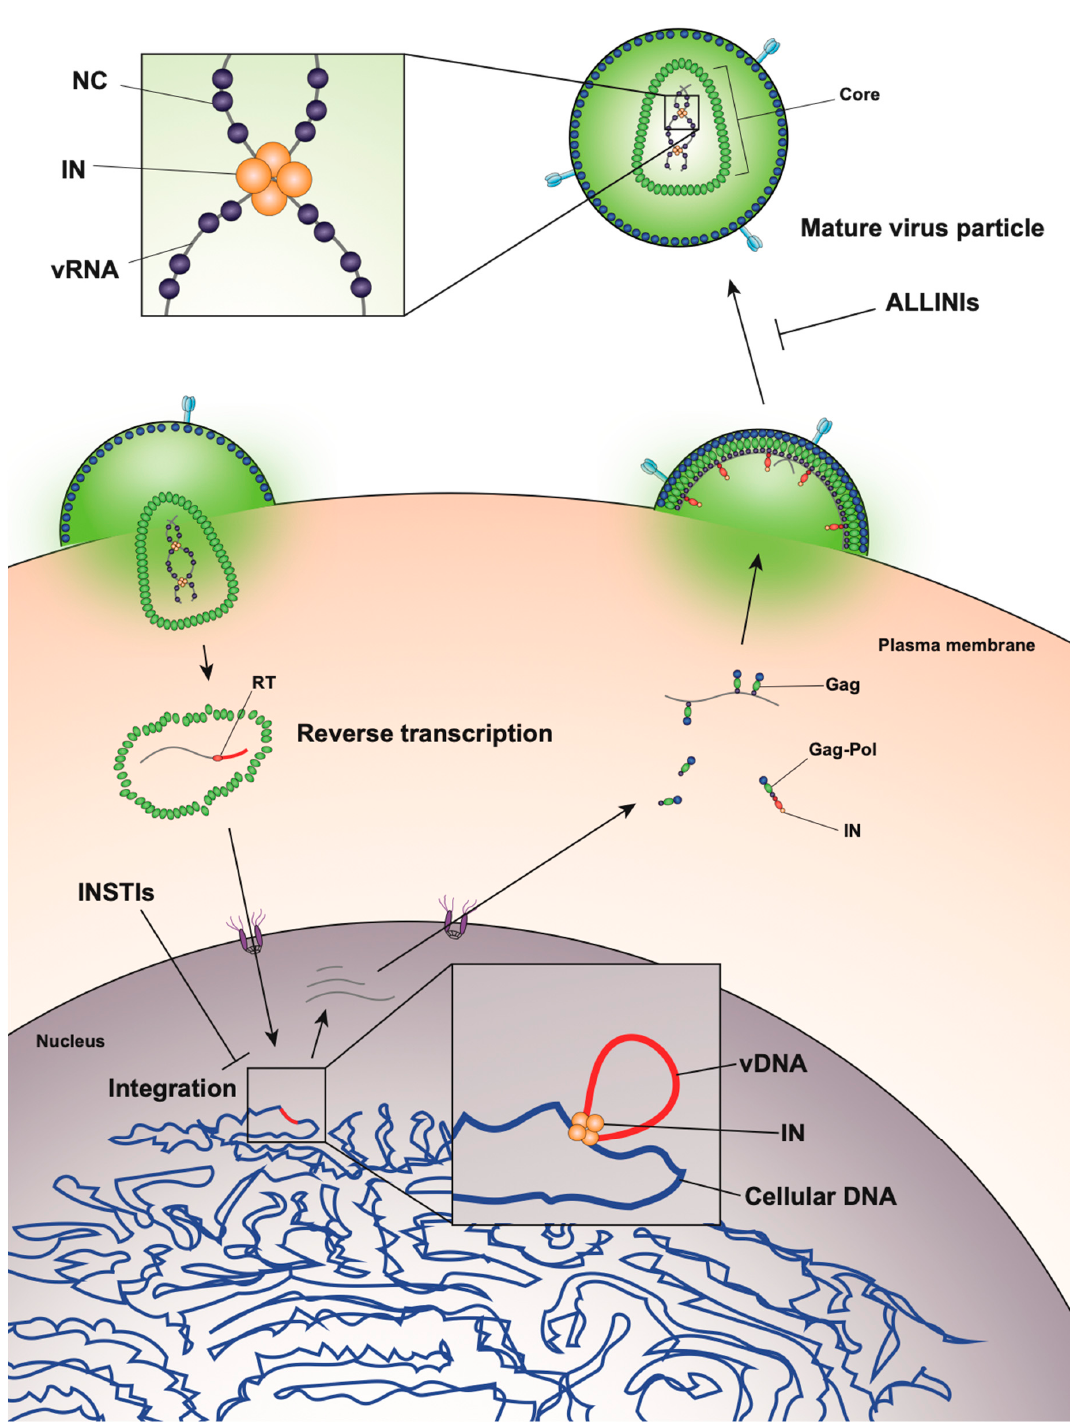
Figure 1. Overview of the human immunodeficiency virus type 1 (HIV-1) life cycle highlighting the key role of HIV-1 integrase enzyme (IN) at early and late stages of replication.